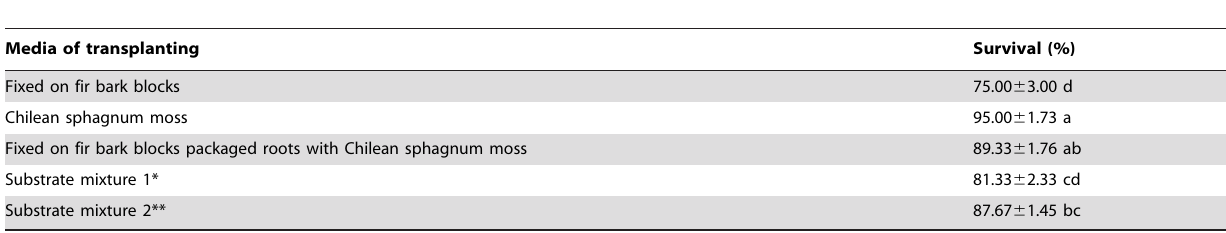
Table 7. Survival of Renanthera imschootiana plantlets grown on different substrates after transplanting for 60 days.